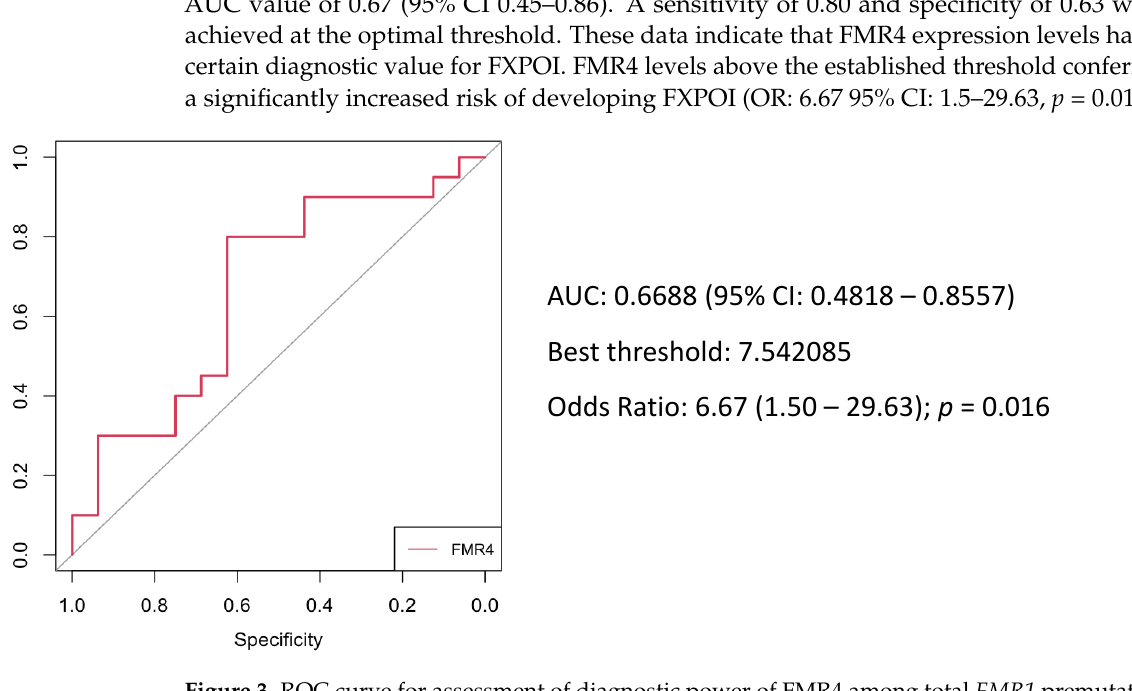
Figure 3. ROC curve for assessment of diagnostic power of FMR4 among total FMR1 premutation female carriers. The area under the curve (AUC) was 0.67.